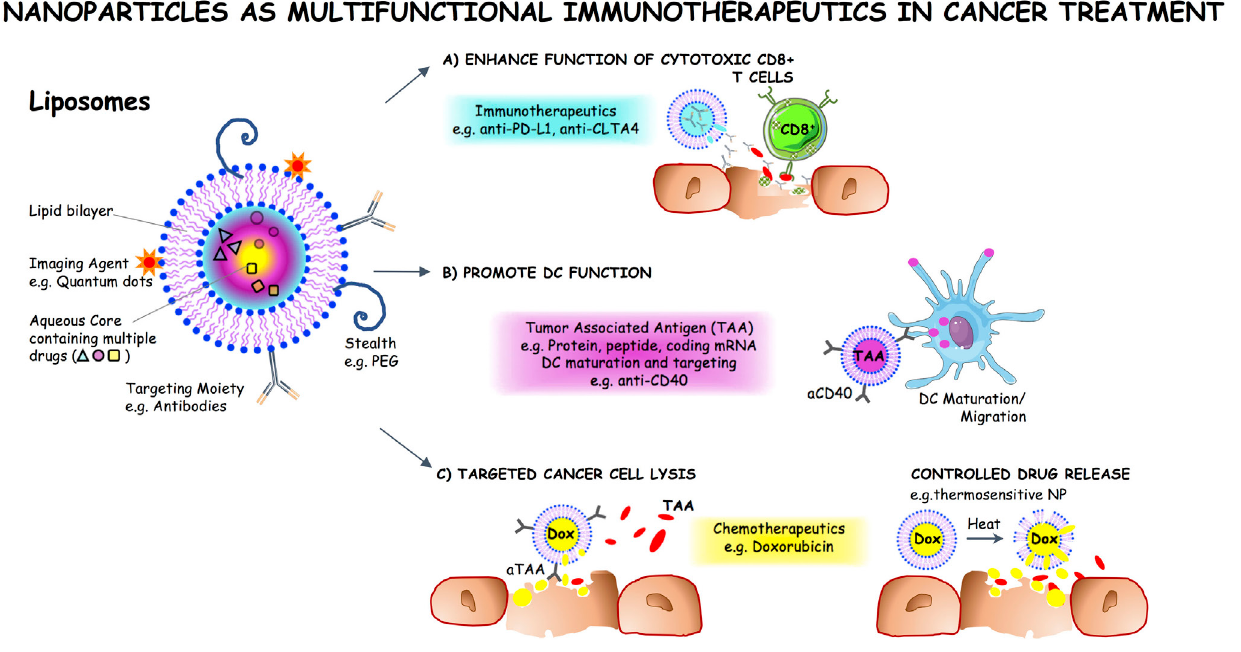
FiguRe 3 | Multifunctional nanoparticles (NP) in cancer treatment. NP can be tailored to specific applications in tumor immunotherapy using versatile designs of various sizes, constituent biomaterials, and surface modifications. The surface of NP can be functionalized with specific polymers and antibodies to increase their targeting to certain types of cells. Liposomes are self-assembling nanosized vesicles comprised of phospholipids and cholesterol arranged in one or more lipid bilayers enclosing an aqueous core. NP such as liposomes can be used as platforms for the simultaneous delivery of multiple agents, such as (A) immunotherapeutics, e.g., anti-PD-L1 and anti-cytotoxic T lymphocyte antigen-4 (CTLA-4), to enhance the function of tumor-specific effector T cells; (B) tumor-associated antigens (TAA) and adjuvant targeted to dendritic cells (DC) to promote their function; (C) chemotherapeutics and targeted release thereof, for instance, using thermosensitive NP, to promote cancer cell